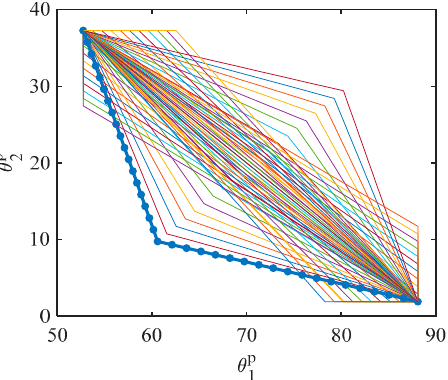
Figure 20. All iterated pre-defined paths and final pre-defined path in case 1.